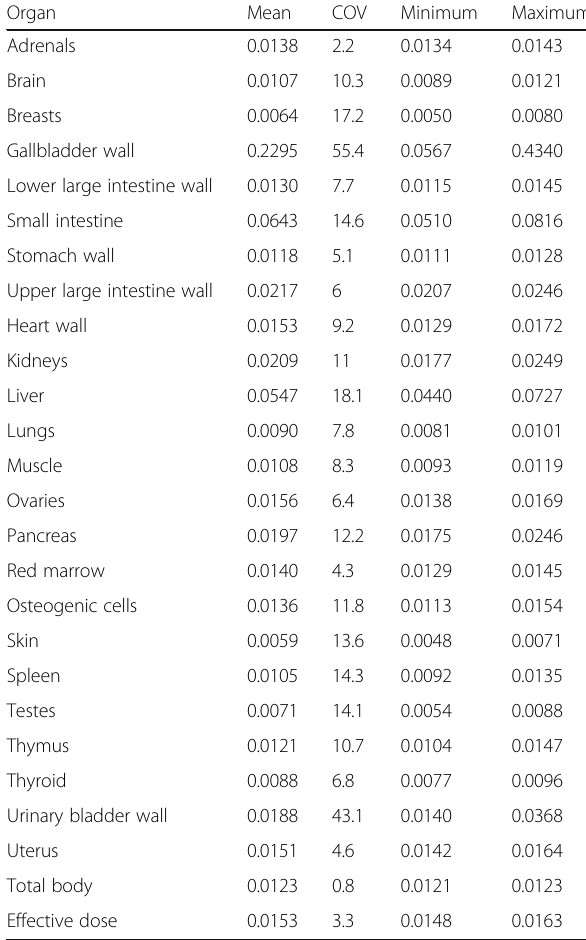
Table 3 Absorbed organ dose (mGy/MBq) and effective dose (mSv/MBq) after injection of [ 18 F]-PSS232. Coefficients of variation (COV) (ratio of SD to